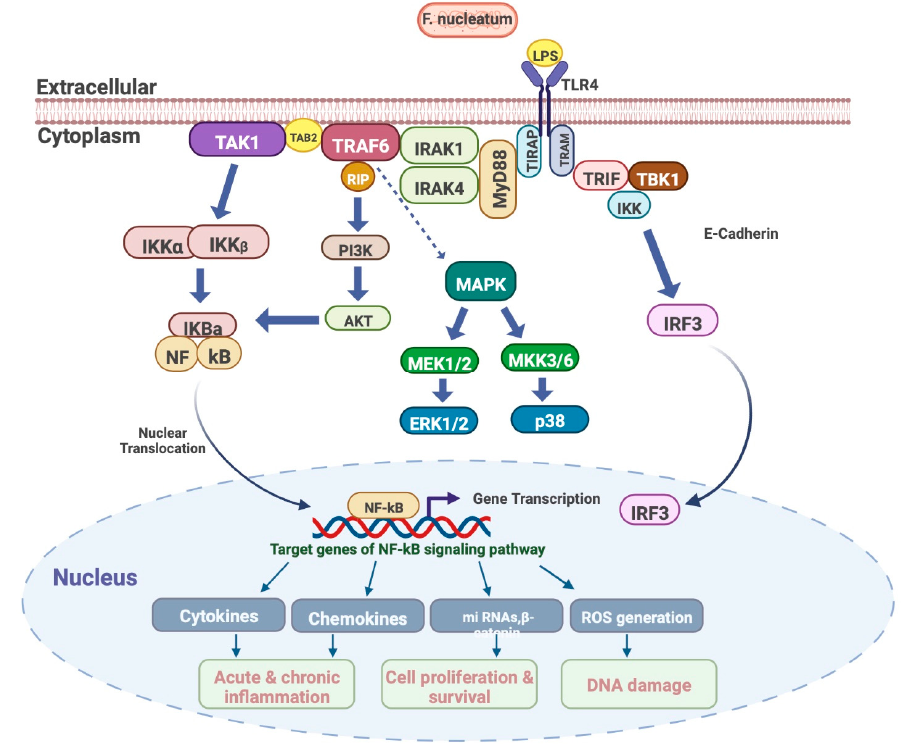
Figure 3. Targeting NF- κ B signaling pathway by F. nucleatum LPS.